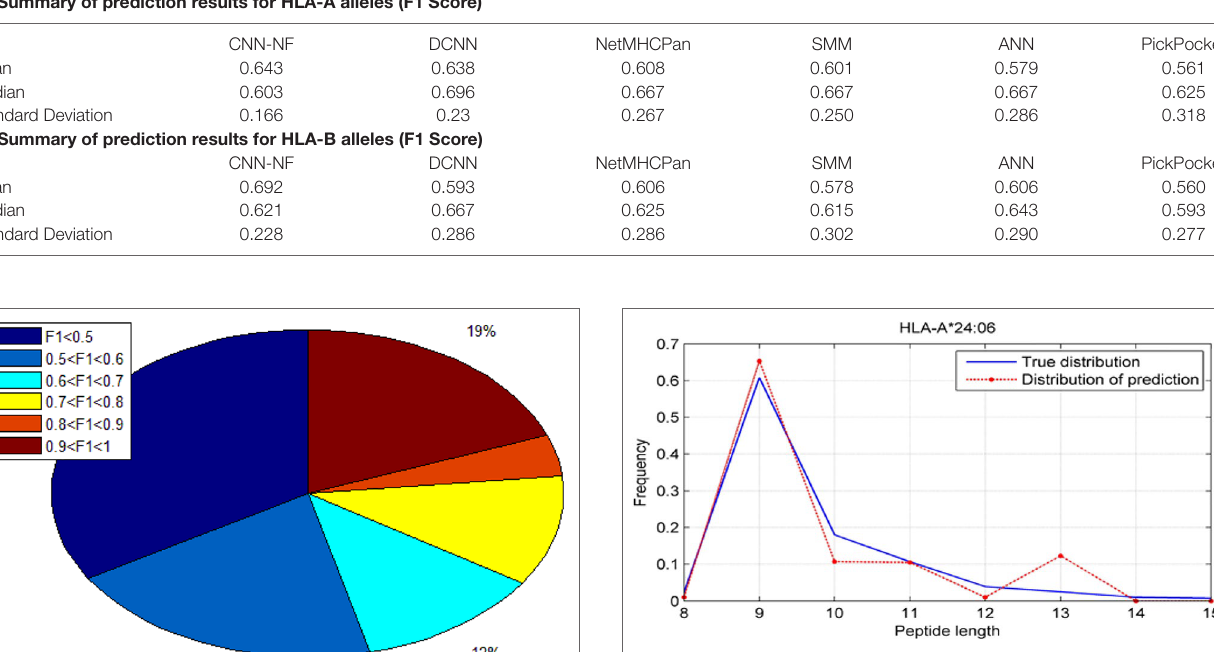
TaBLe 4 | Prediction results for human leukocyte antigen-1 (HLA-I) alleles(A). (a) summary of prediction results for HLa-a alleles (F1 score)